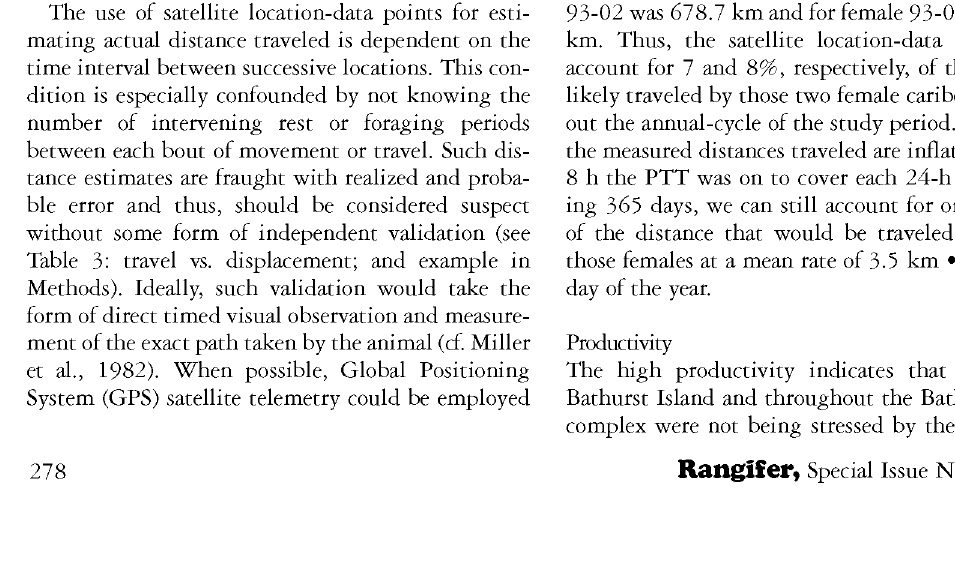
Table 3: travel vs. displacement; and example in Methods). Ideally, such validation would take the form of direct timed visual observation and measure¬ ment of the exact path taken by the animal (cf. Miller et al., 1982). When possible, Global Positioning System (GPS) satellite telemetry could be